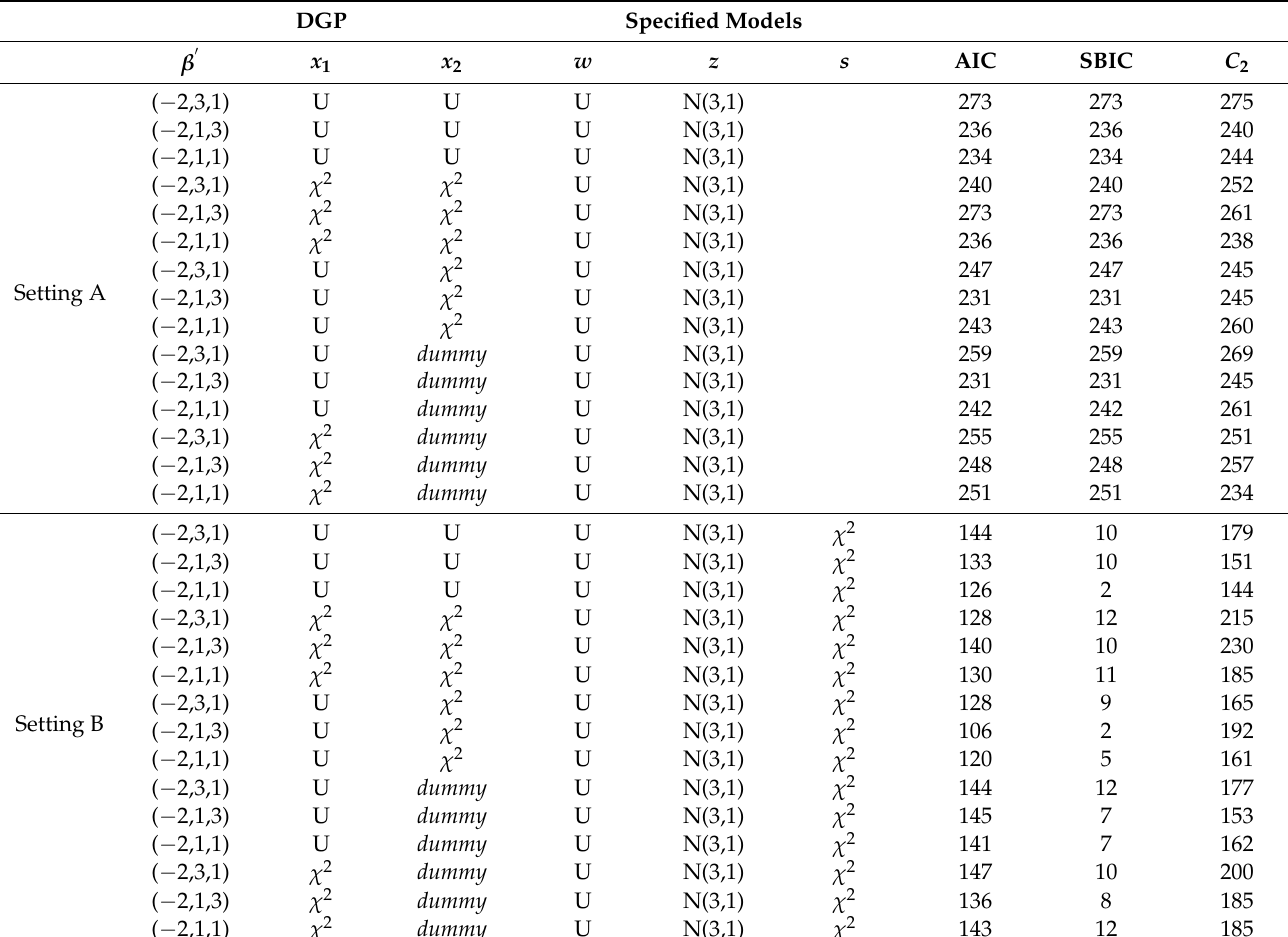
Table 2. Behaviour of the selection criteria in Case1.1 N = 2000. DGP Specified